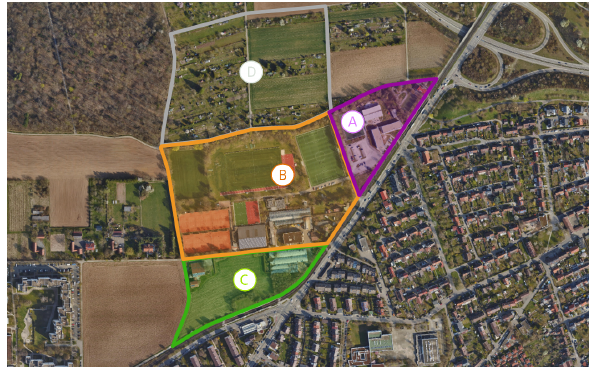
Figure 1. Area Weilimdorf (Imagery provided by the city of